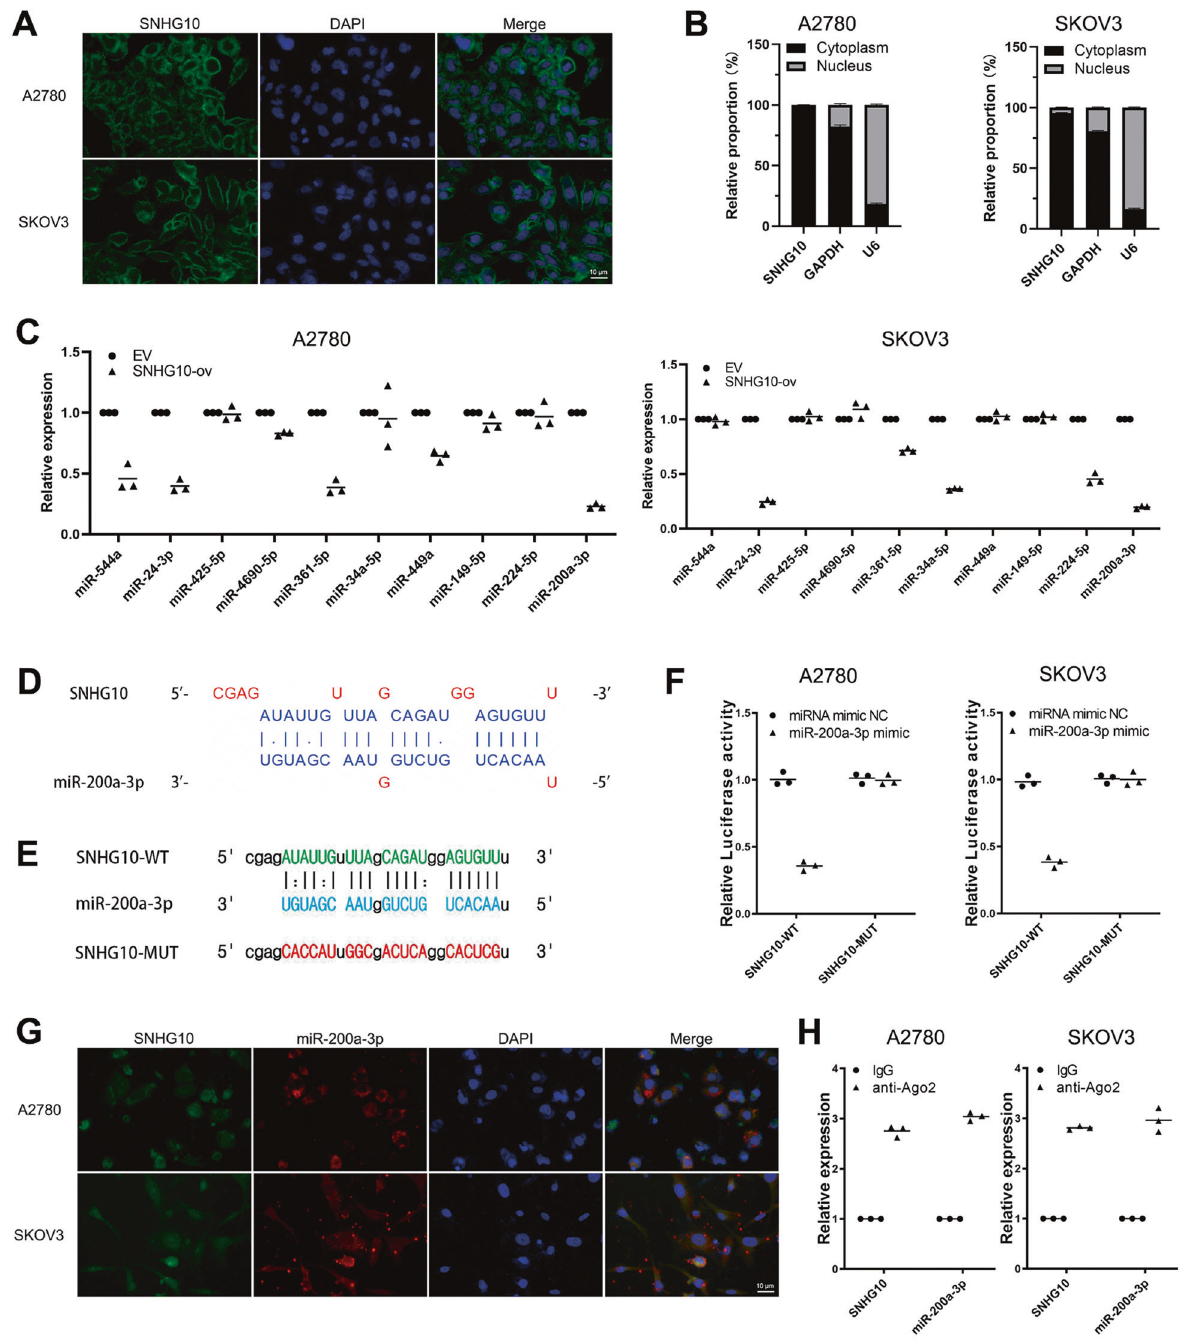
Fig. 3 SNHG10 sponges miR-200a-3p in EOC cells. A SNHG10 located in the cytoplasm of EOC cells. B The nuclear and cytoplasmic distribution of SNHG10 in A2780 and SKOV3 cells. C Altered expressions of miRNAs in A2780 cells after overexpressing SNHG10. D The predicted binding between miR-200a-3p and SNHG10, analyzed with LncBase v.2 experiment module. E The sequences of SNHG10-WT and SNHG10-MUT. F miR-200-3p mimic decreased the luciferase activity in EOC cells transfected with SNHG10-WT but not in the cells transfected with SNHG10-MUT. G SNHG10 and miR-200a-3p were co-located in the cytoplasm of EOC cells. H RIP was performed using AGO2 antibody in A2780 and SKOV3 cells, the enrichments of SNHG10 and miR-200a-3p were detected by qRT-PCR. The experiments were conducted in and SKOV3 cells, while these effects were abolished by and SKOV3 cells. The results showed that the SNHG10 over- cotransfection of miR-200a-3p mimic (Fig. 6B – E). expression led to increased expression of E-cadherin and We next detected BIN1 expression in EOC specimens by decreased expression of N-cadherin, Vimentin and SNAIL, while immunohistochemistry (IHC) and analyzed its correlation with cotransfection of miR-200a-3p mimic neutralized this phenom- prognosis. BIN1 staining was mainly located in the nucleus of enon (Fig. 6A). SNHG10 overexpression signi fi cantly inhibited the cancer cells in EOC tissues (Fig. 7A). Among 85 EOC specimens, 45 proliferation, colony formation, migration and invasion of A2780